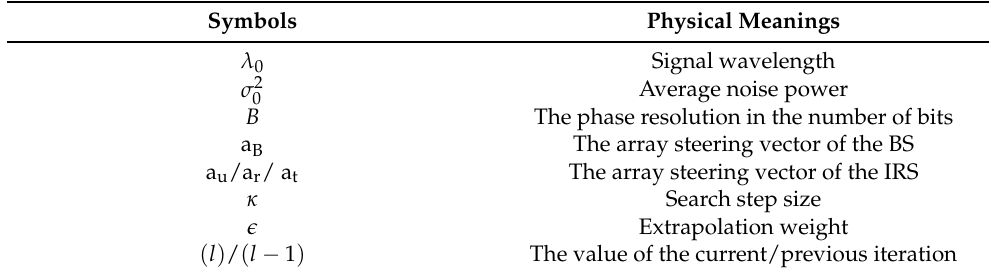
Table 1. Symbols and their physical meanings. Symbols Physical Meanings λ 0 Signal wavelength Average noise power σ 2 0 B The phase resolution in the number of bits a B The array steering vector of the BS a u /a r / a t The array steering vector of the IRS κ Search step size (cid:101) Extrapolation weight ( l ) / ( l 1 ) The value of the current/previous −